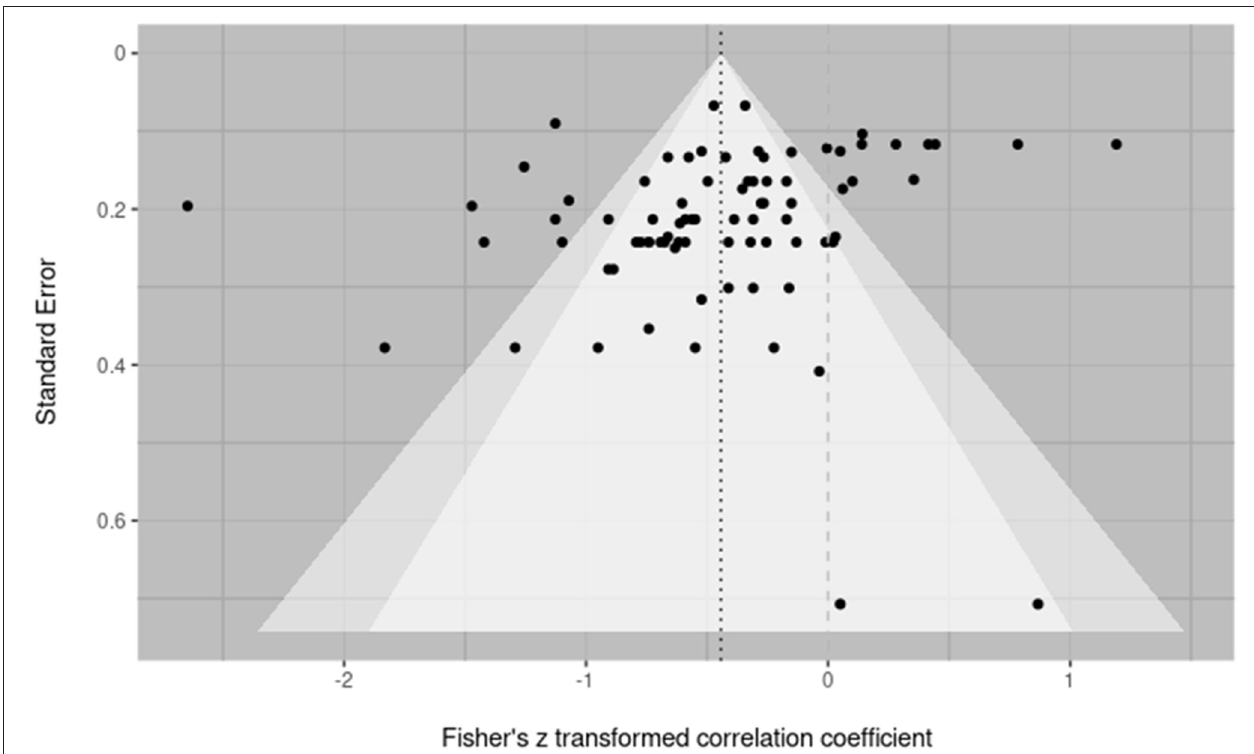
FIGURE 3 | Contoured funnel plot of all effect sizes. Fisher’s Z transformed correlation coefficients for each reported effect size are plotted against the standard error. The dark dashed line indicates the summary effect size on which the funnel is centered. The lighter dashed line indicates a null effect. The funnel is centered on the summary effect size. Egger’s regression suggests mild asymmetry present in the plot (z = –1.7653; p =